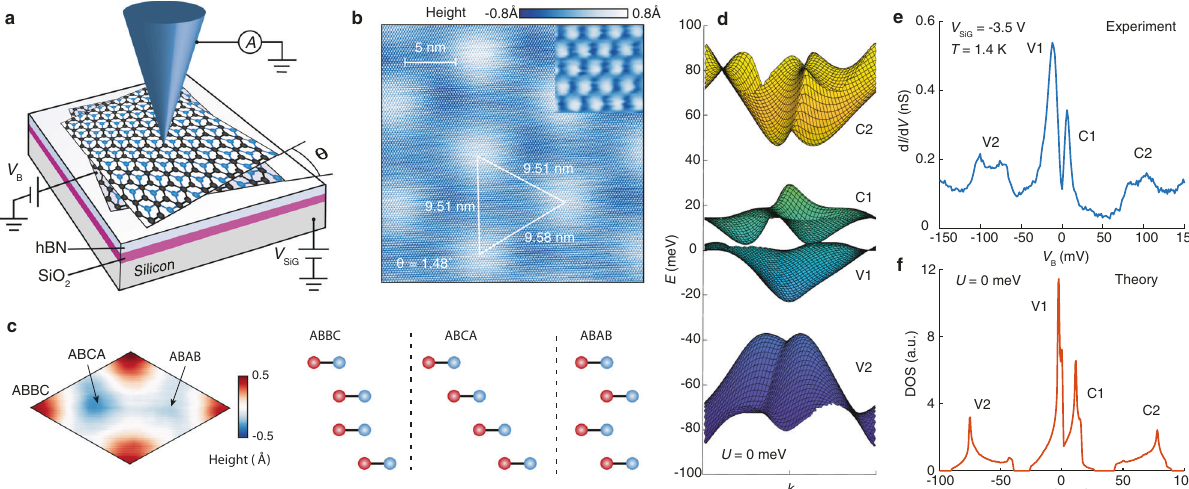
Fig. 1 STM on TDBG. a Schematic of the STM measurement setup on TDBG devices. b STM topograph of TDBG, obtained with bias setpoint V set = − 400 mV, current setpoint I set = 20 pA and gate voltage V SiG = − 88 V. Top right inset shows magni fi ed image (1 nm size) with top graphene layer lattice in a Bernal bilayer. The bright spots in the inset are carbon atoms. c Filtered topograph removing atomic lattices to emphasize different stacking orders of TDBG plotted in the moiré unit cell. The colored circles on the right represent carbon atoms on A and B sublattices of each layer. d Calculated band structure of TDBG with a twist angle of θ = 1.48° under zero potential different between the top and the bottom graphene layers ( U = 0). e Tunneling spectrum of 1.48° TDBG device at charge neutrality, measured with V set = − 400 mV, I set = 400 pA and AC modulation of V mod = 3 mV. f Density of state on the top graphene layer calculated by a continuum model under zero electric fi eld.